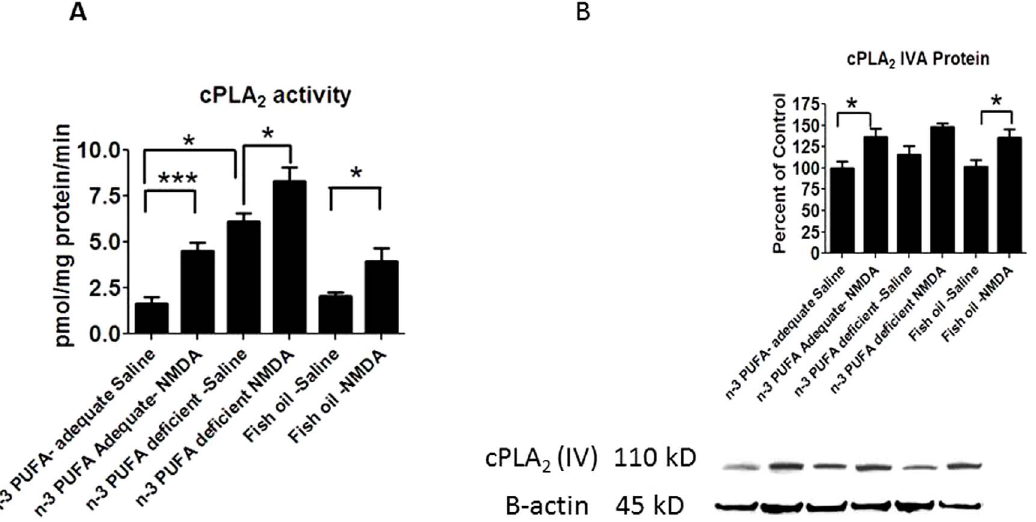
Figure 2. cPLA 2 activity and protein expression. Measured activity of A) cPLA 2 enzymes and B) cPLA 2 protein levels. Data are expressed as mean 6 SEM (n=6 per group for activity, or n=5-6 per group for protein, due to unquantifiable bands). Statistical significance is denoted by * p # 0.05, ** p , 0.01, *** p , 0.001.